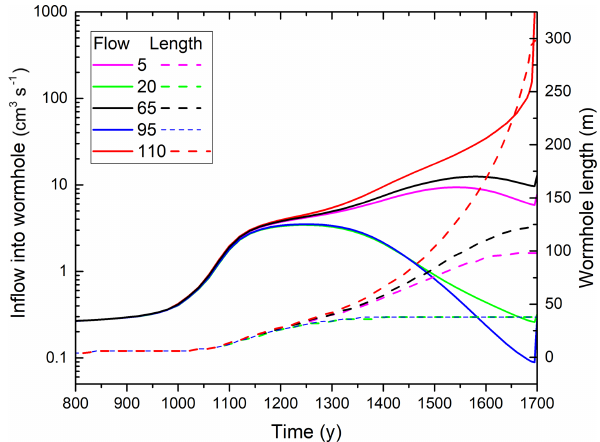
Figure 16. Evolution of input flow rates (solid lines) and wormhole lengths (dashed lines) for the wormholes marked in Fig.